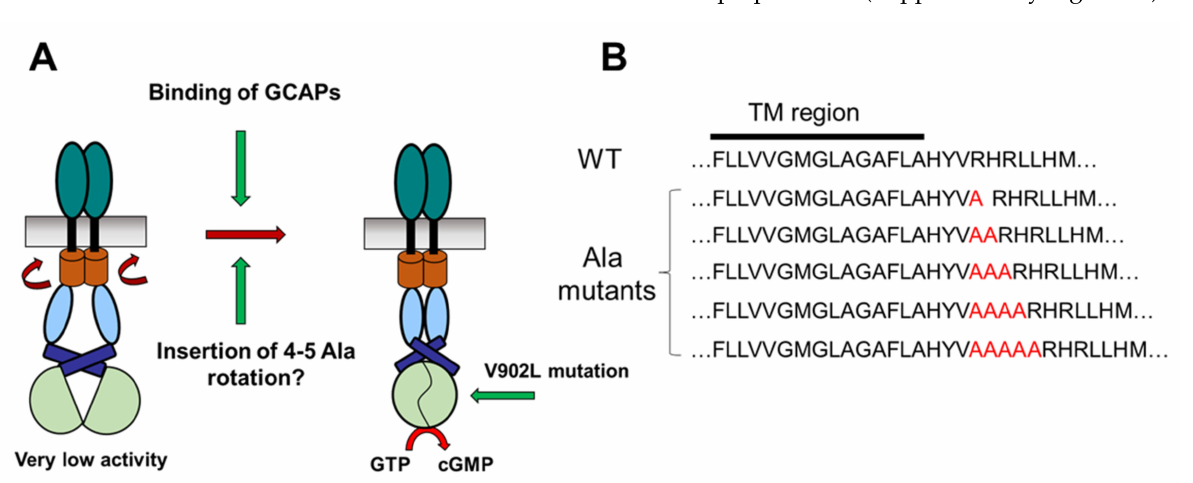
Figure 1. Hypothesis regarding photoreceptor GC-E reaching the active state. ( A ) Activation of GC-E by GCAPs could trigger a rotation in the cytoplasmic part of GC-E, leading to the active state. The point mutation V902L leads to a constitutively active state of human GC-E [27]. ( B ) Insertion of Ala residues (red) after the TM region of human